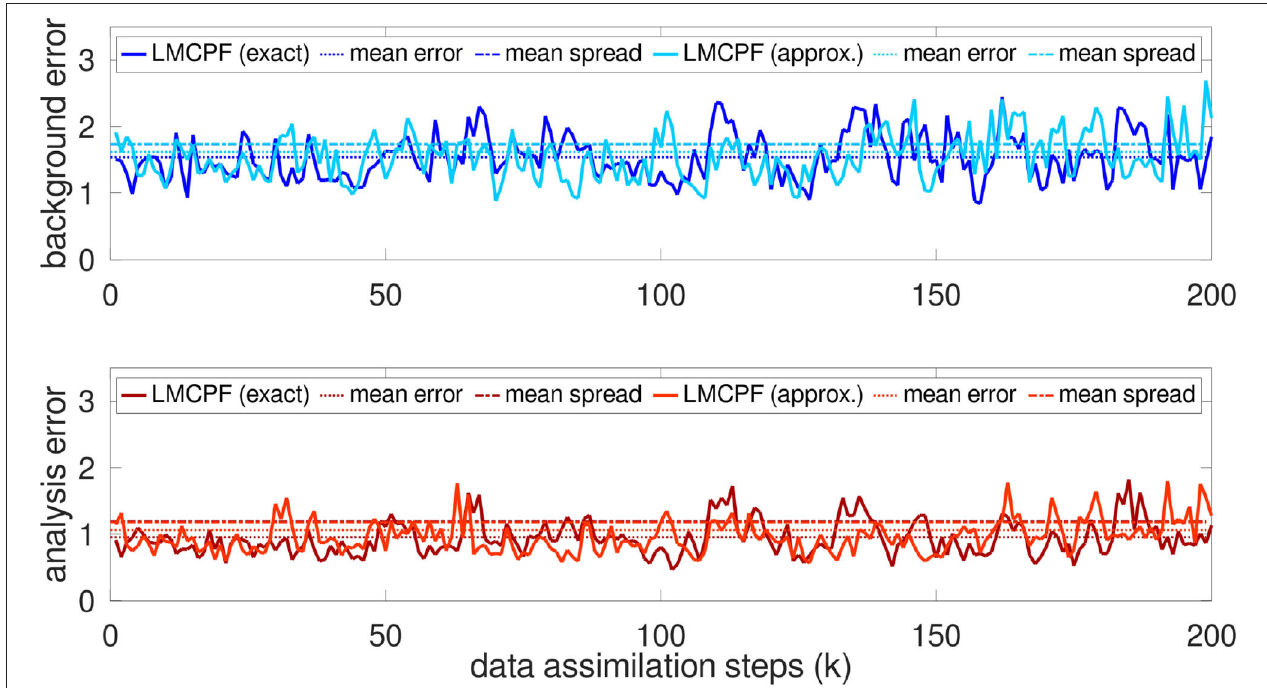
FIGURE 9 | The evolution of the background and analysis errors [see Equations (115) and (116)] for LMCPF with exact and approximate weights is illustrated for the last 200 data assimilation steps of an experiment over 1,000 steps. For both methods, the ensemble size is set to L 40-dimensional Lorenz 1996 model is observed. The forcing terms are set to F true standard deviation is chosen as σ obs κ 1.1 for the LMCPF with exact weights and to κ = steps of the LMCPF with exact weights equals e ( b ) approximate weights are given by e ( b )